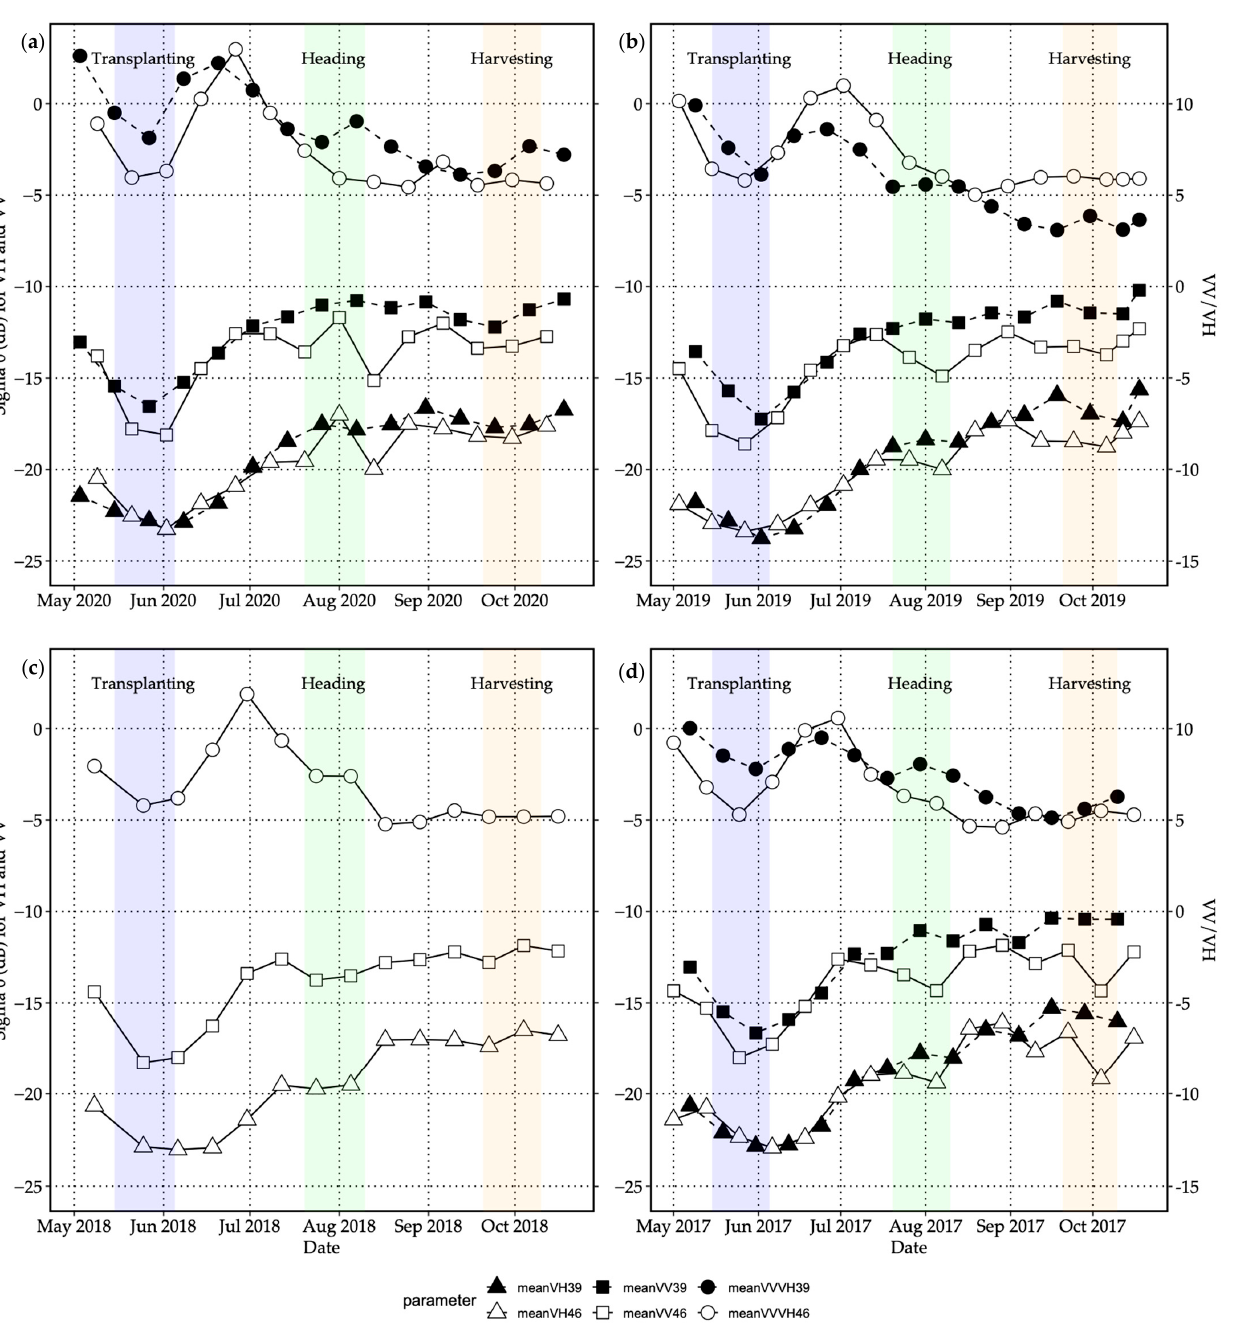
Figure 5. Time-series changes in σ 0VV (triangles), σ 0VH (squares), and VV/VH (circles) for ( a ) 2020, ( b ) 2019, ( c ) 2018, and ( d ) 2017 for orb 39 (solid) and orb 46 (blank). Data in orb 39 were missing in 2018; thus, they were excluded from the analysis.